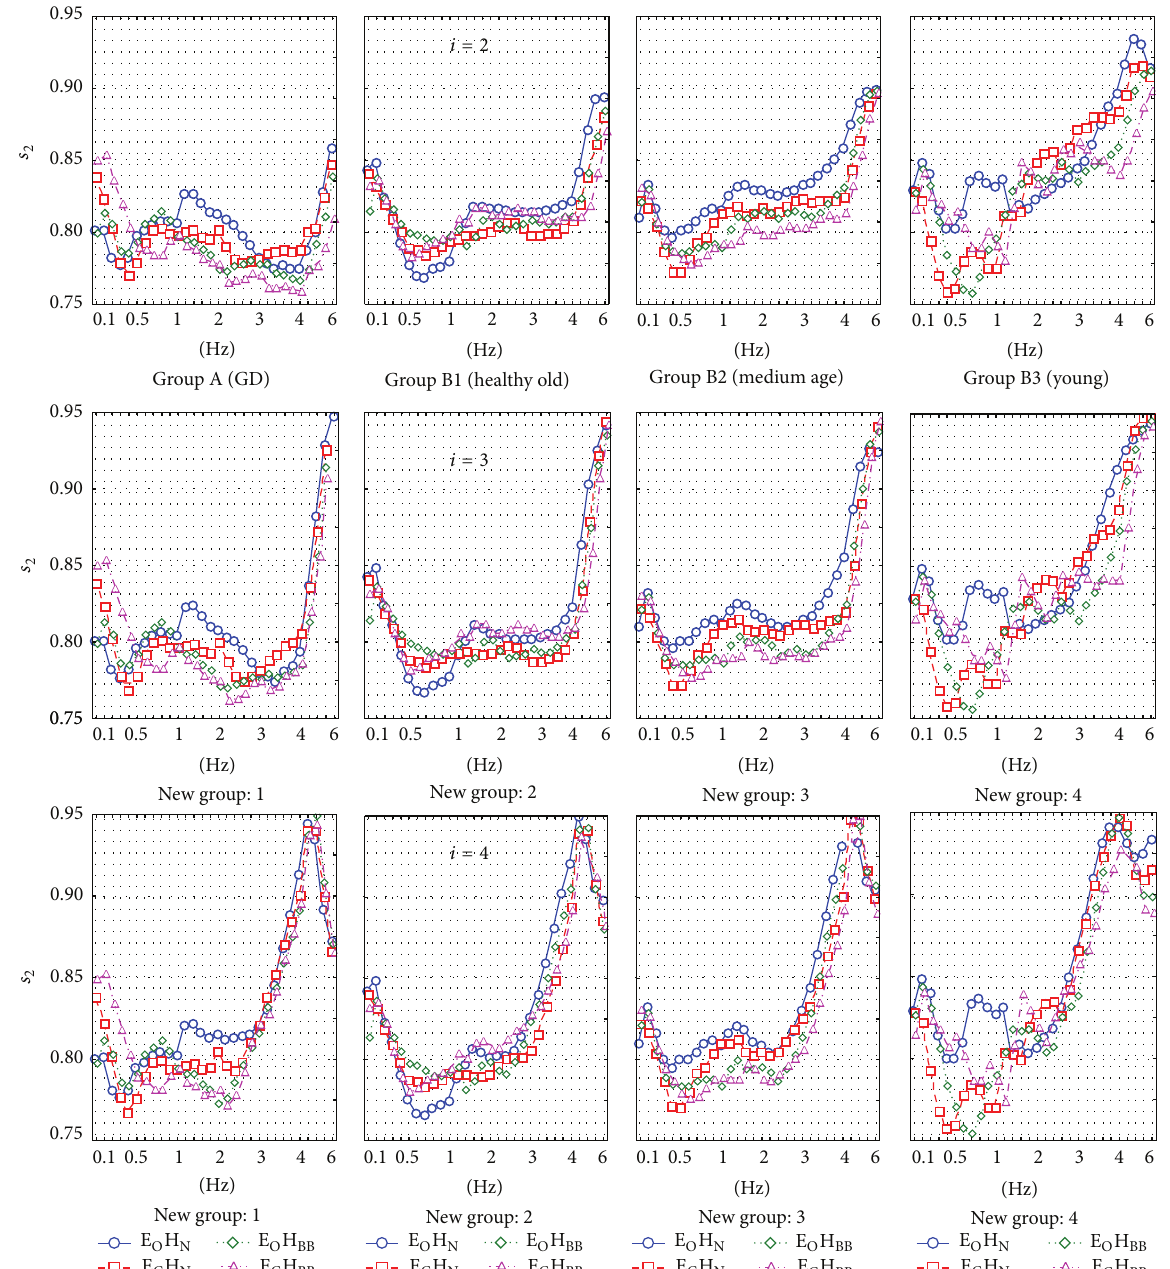
Figure 3: The detailed 𝑠 2 values obtained in successive patient groups for different registration methods. Three rows represent different number of columns ( 𝑖 ) in PCA